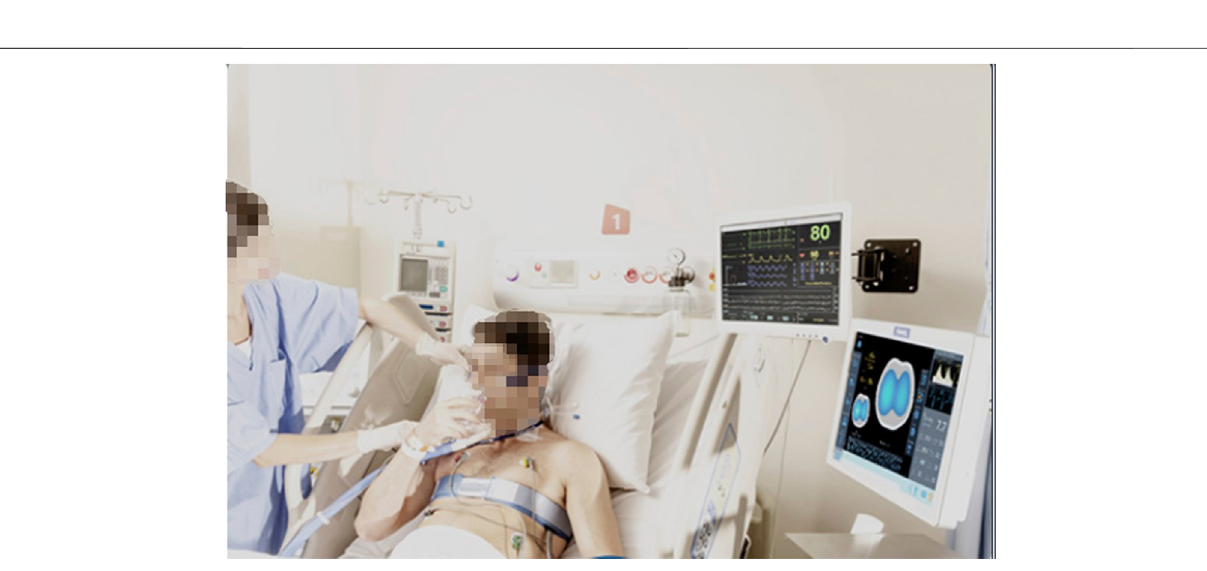
Frontiers in Bioengineering and Biotechnology |